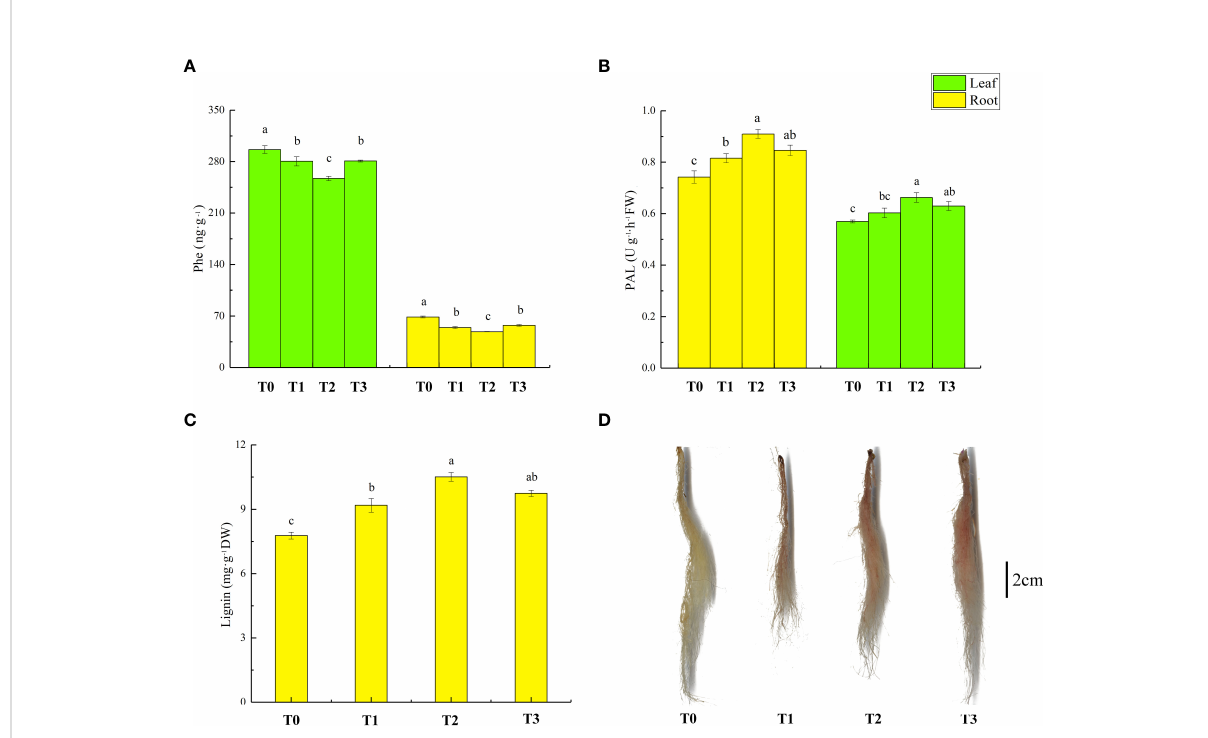
FIGURE 6 Effect of ZnONPs on Phe content (A) and PAL activity (B) in leaves and roots of lettuce, and lignin content (C) roots of lettuce and visualization of lignin staining in lettuce roots (D) . T0, no treatment; T1, exposure to 1 mg/l Cd; T2, exposure to 1 mg/l Cd and 2.5 mg/l ZnONPs; T3, exposure to 2.5 mg/l ZnONPs. The small amount of reddish-brown color indicates that the lignin accumulation in the roots is low, bar = 2cm. Data are shown as means ± SE of three replicates. Bars marked by different letters indicate signi fi cant differences according to Duncan ’ s test ( p